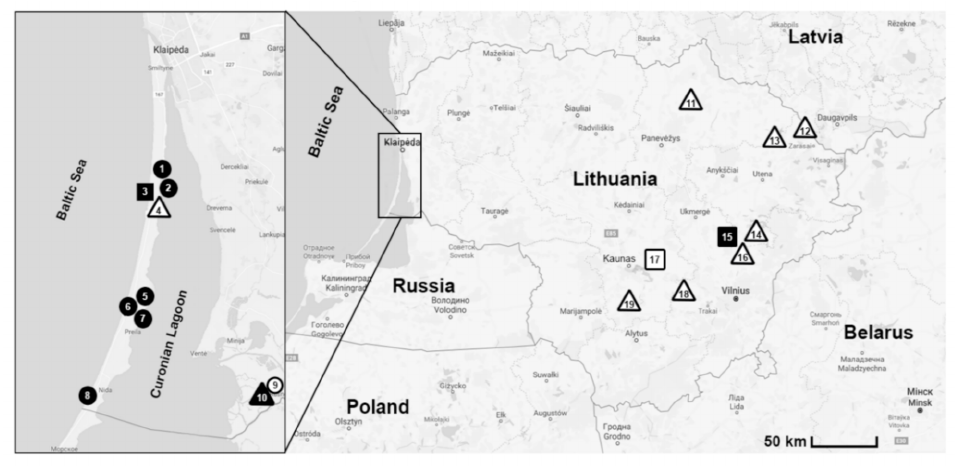
Figure 1. Rodent trapping sites in Lithuania, 2013–2017. ∆ / (cid:78) —forests; ◦ / • —meadows; (cid:3) / (cid:4) — ecotones; ∆ / ◦ / (cid:3) —rodents negative for Babesia parasites; (cid:78) / • / (cid:4) —rodents infected with